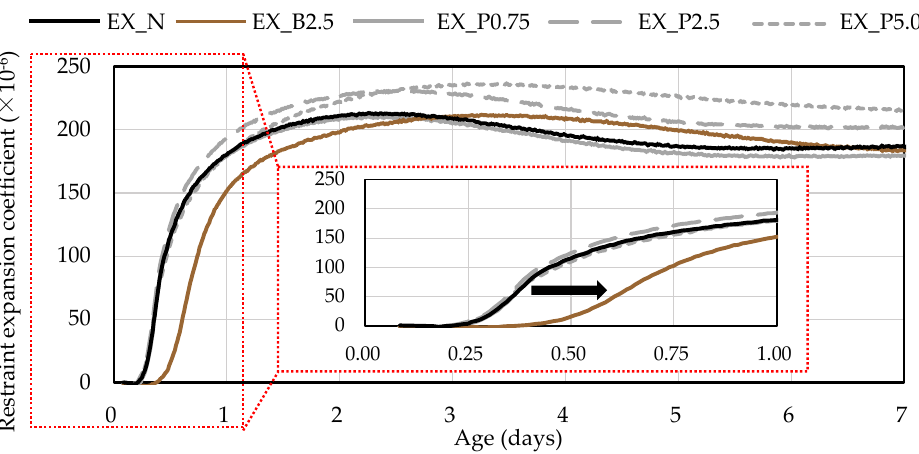
Figure 6. Expansion coefficient under restraint condition in expansive mortars.